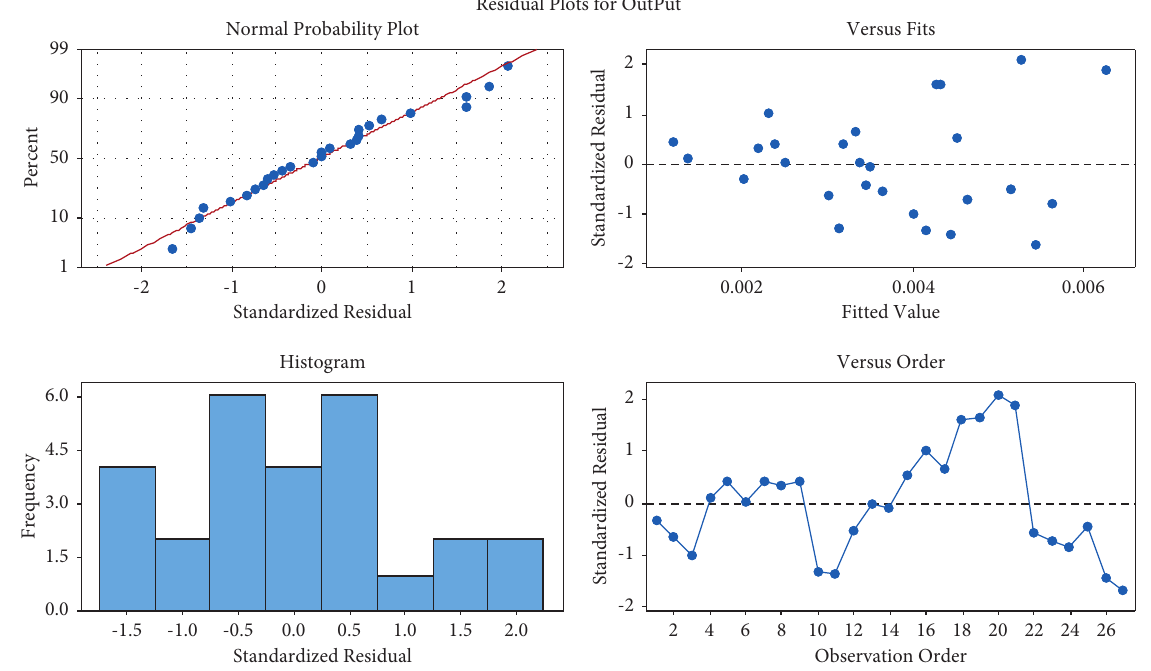
Figure 6: Residual plot output on dry sliding wear test.